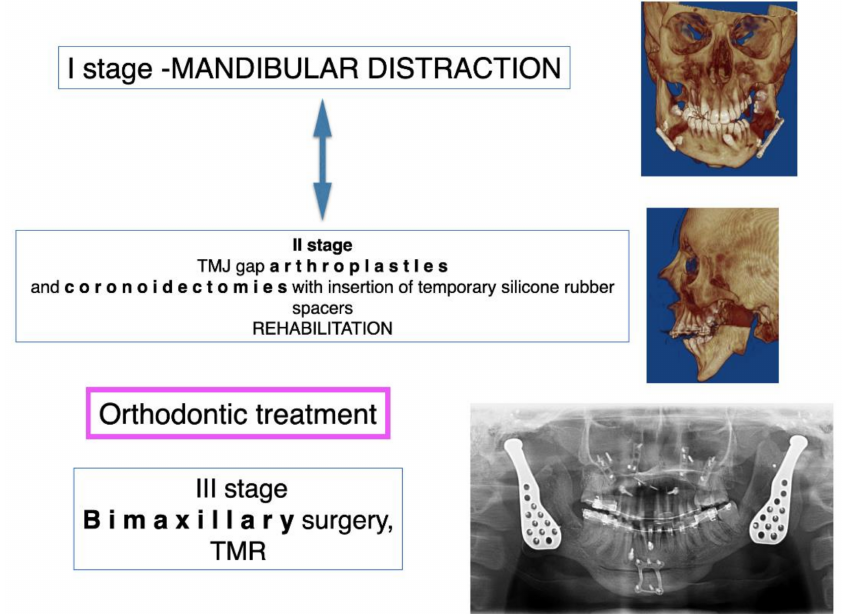
Figure 2. Protocol for multi-stage treatment of advanced TMJ ankylosis in teenagers and adolescents, leading to the final facial reconstruction. The first stage is mandibular osseodistraction, which produces a stable osseous base and stretches the fibrotic and slightly contracted soft tissue. The second stage consists of ankylotic block removal and gap arthroplasty involving the placement of interpositional material, e.g., silicone. At this stage, intensive physiotherapy is being conducted, and thanks to the restoration of proper mouth opening, the patient may receive orthodontic treatment. In some cases, when the mouth opening is sufficient for the orthodontic treatment or when it is more important to restore the opening, it is possible to switch between the first and second stages. The third and final stage includes orthognathic surgery along with the insertion of TMJ implants.